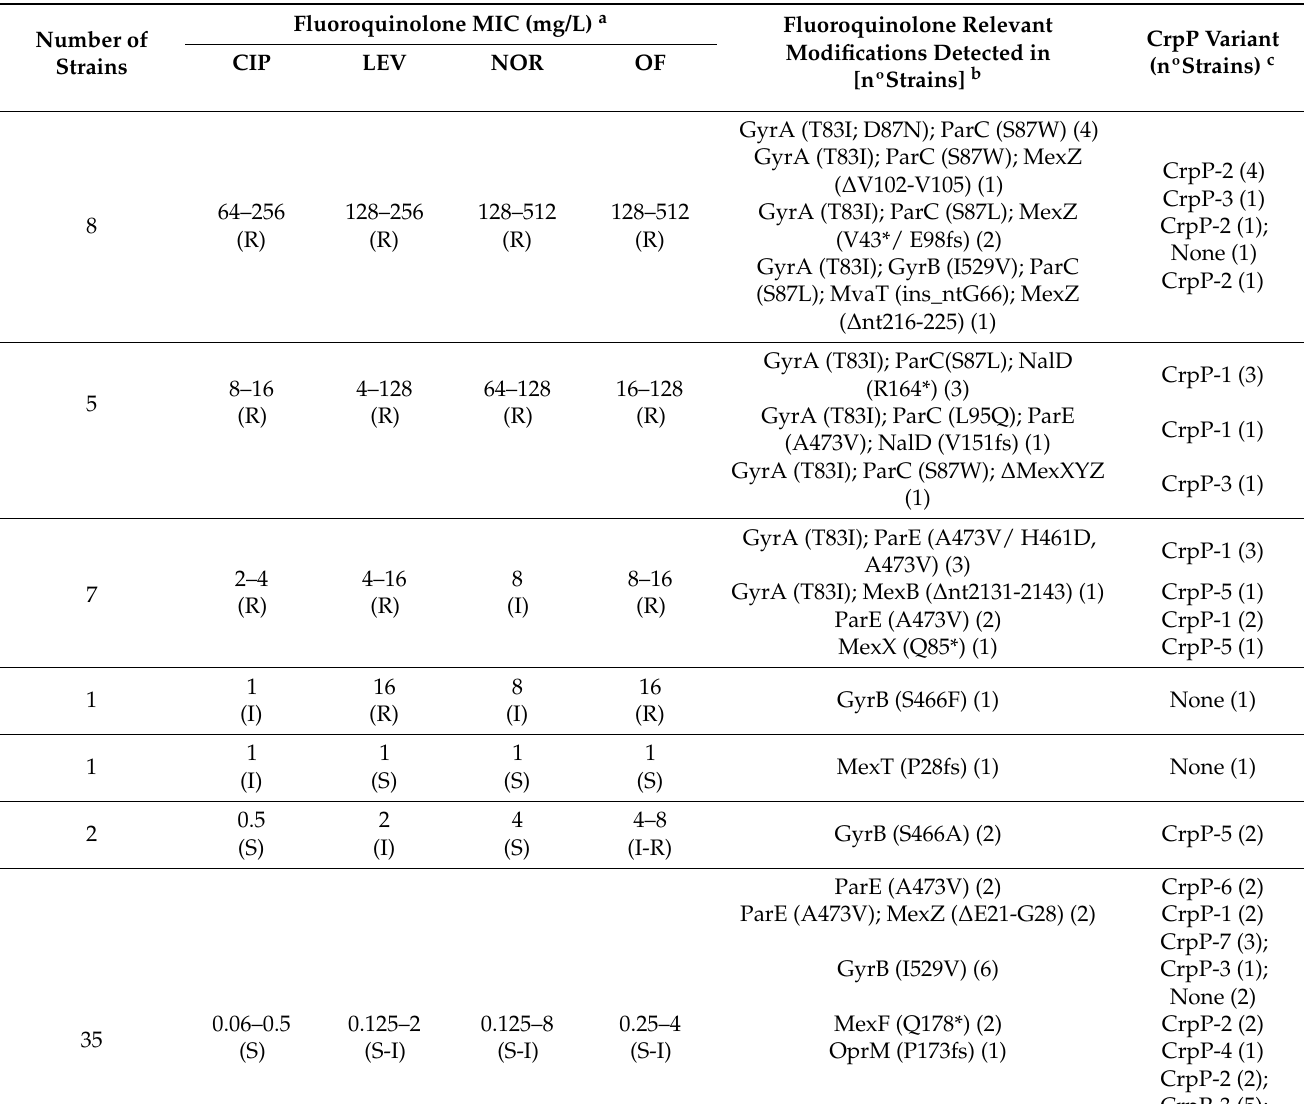
Table 1. Fluoroquinolone Resistance Levels and Associated Changes Detected in the Strains included in this